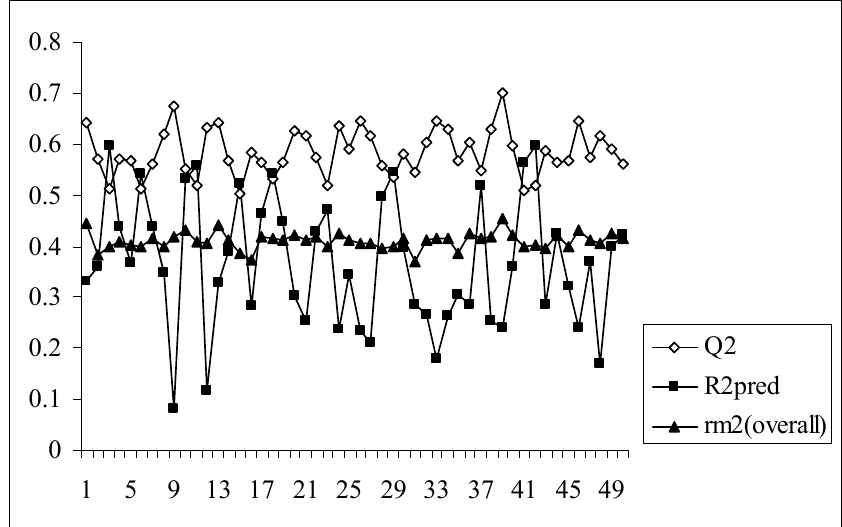
and r m2 values of 50 models (data set pred (overall)